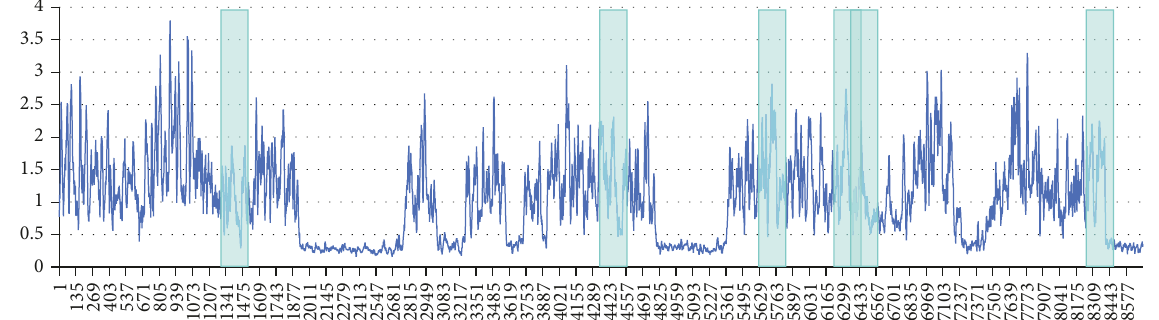
Figure 4: A time-series of acceleration signals. It is found that the most repeated pattern was 𝑏𝑐𝑐𝑎𝑏𝑐𝑎𝑎 which occurs 6 times.